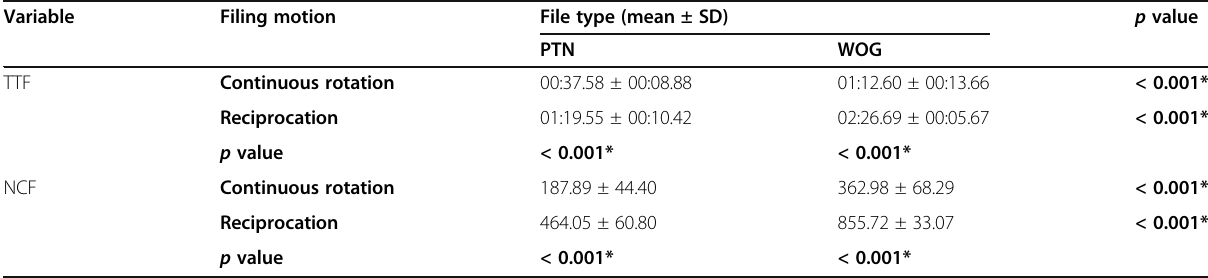
Table 1 Comparison of simple main effects